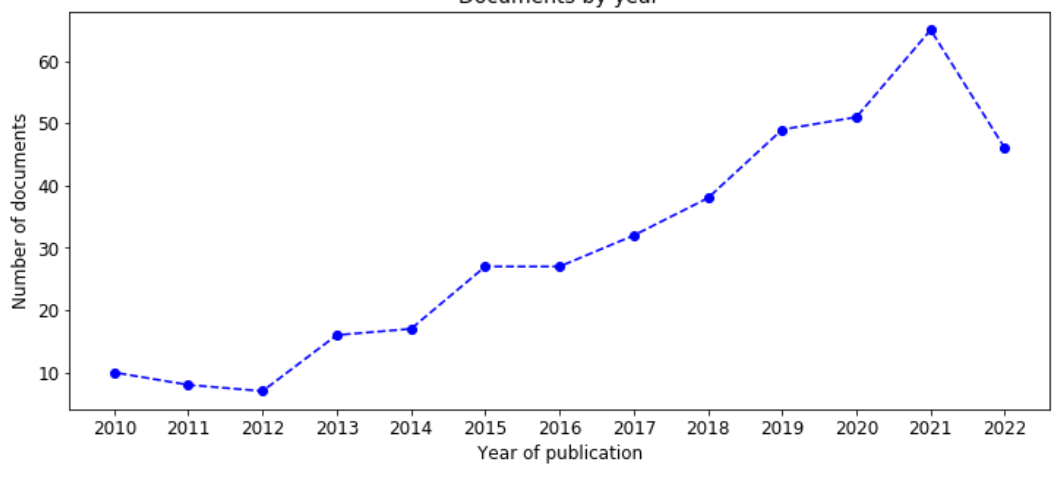
Figure 1. The distribution of documents is grouped by year of publication (PubMed, IEEE Xplore and